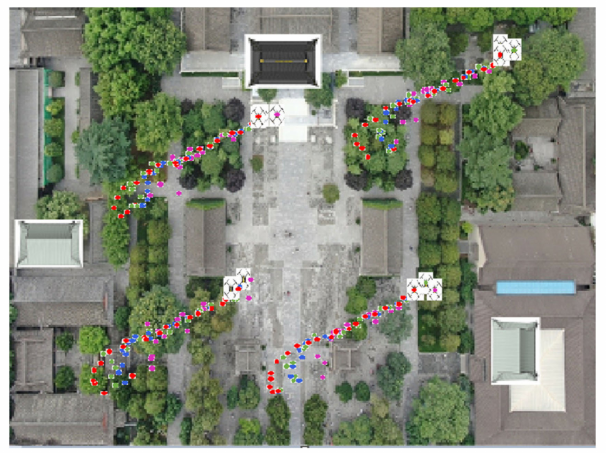
Figure 9. LS, UKF, ANN, UCP-IG method positioning trajectory (experimental random scenario).